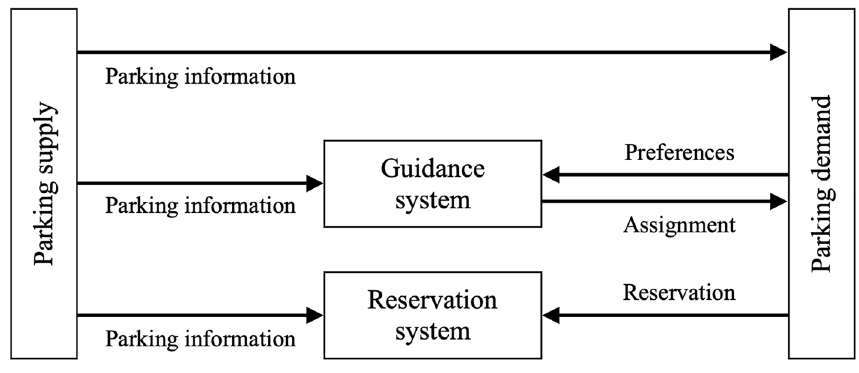
Figure 1. Typologies of intelligent parking